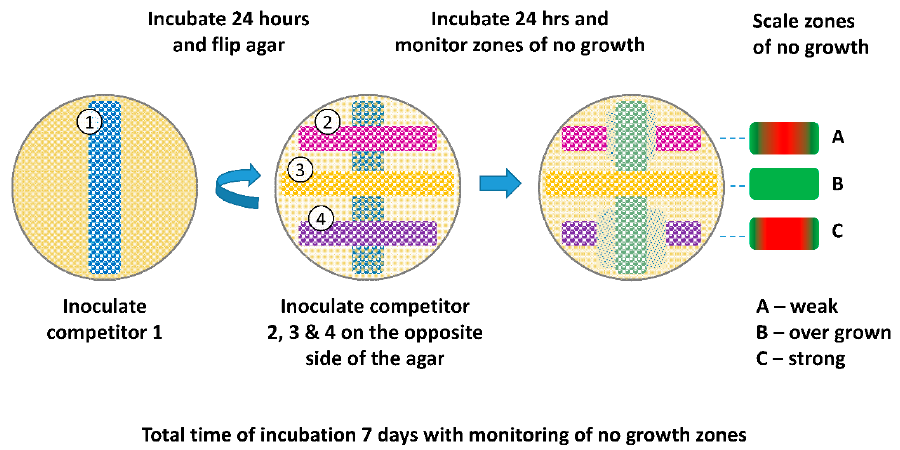
Figure 2. Schematic of Omelette method. Competitor strains were streaked on both surfaces of a 4 mm MAC plate. The bottom strain was streaked and grown for 24 h at 37 °C. After 24 h, the agar was flipped and three strains were streaked perpendicular to the bottom strain, separated by the thickness of the agar. Plates were then incubated for an additional 24 h and examined for zones of no growth graded by a scale of 1-to-10. Plates were incubated for another 6 days (7 days total) to monitor changes in zones of no growth. Agar thickness of 4, 7, and 10 mm were evaluated.